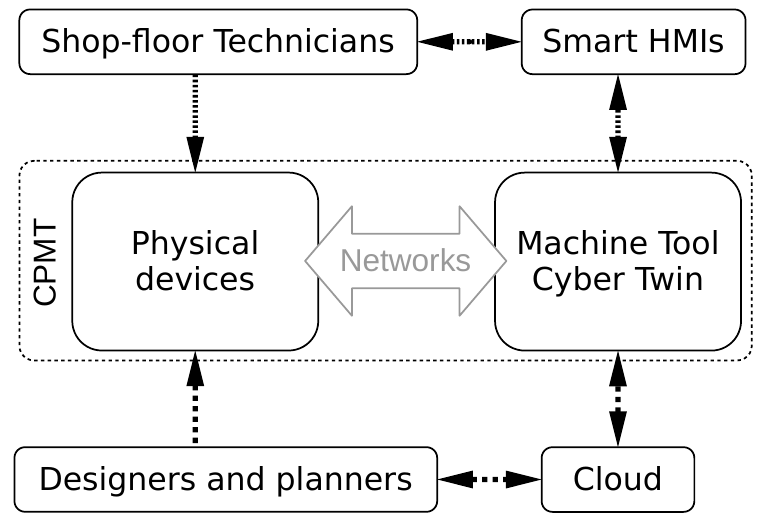
Figure 1. Generic system architecture for CPMT. Adopted from